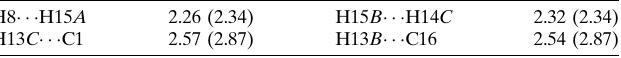
Figure 1 Synthesis of (1 R ,5 S